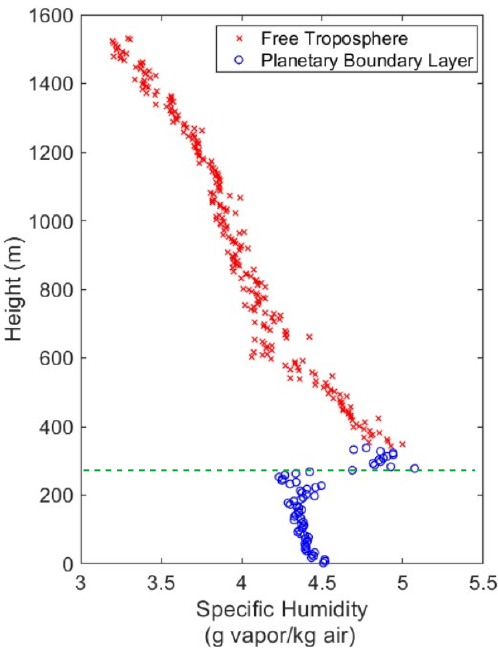
Figure 6. The Calinski–Harabasz criterion index (CHCI) applied to the sampling flight on 12 June with a priori assumption of K = 2. Groups are assumed to represent the free troposphere and PBL, though more structure may exist. The boundary at ∼ 325m using CHCI is not in agreement with that determined using the Euclid- ian distance in Fig. 7, which shows a likely boundary at ∼ 275m. This value was chosen by the operator of the flight and shown as the dashed green line. Figure 10 shows an example of a failure in Euclidian distance to predict the boundary layer. The use of CHCI improves the PBL prediction algorithm, as determined in this